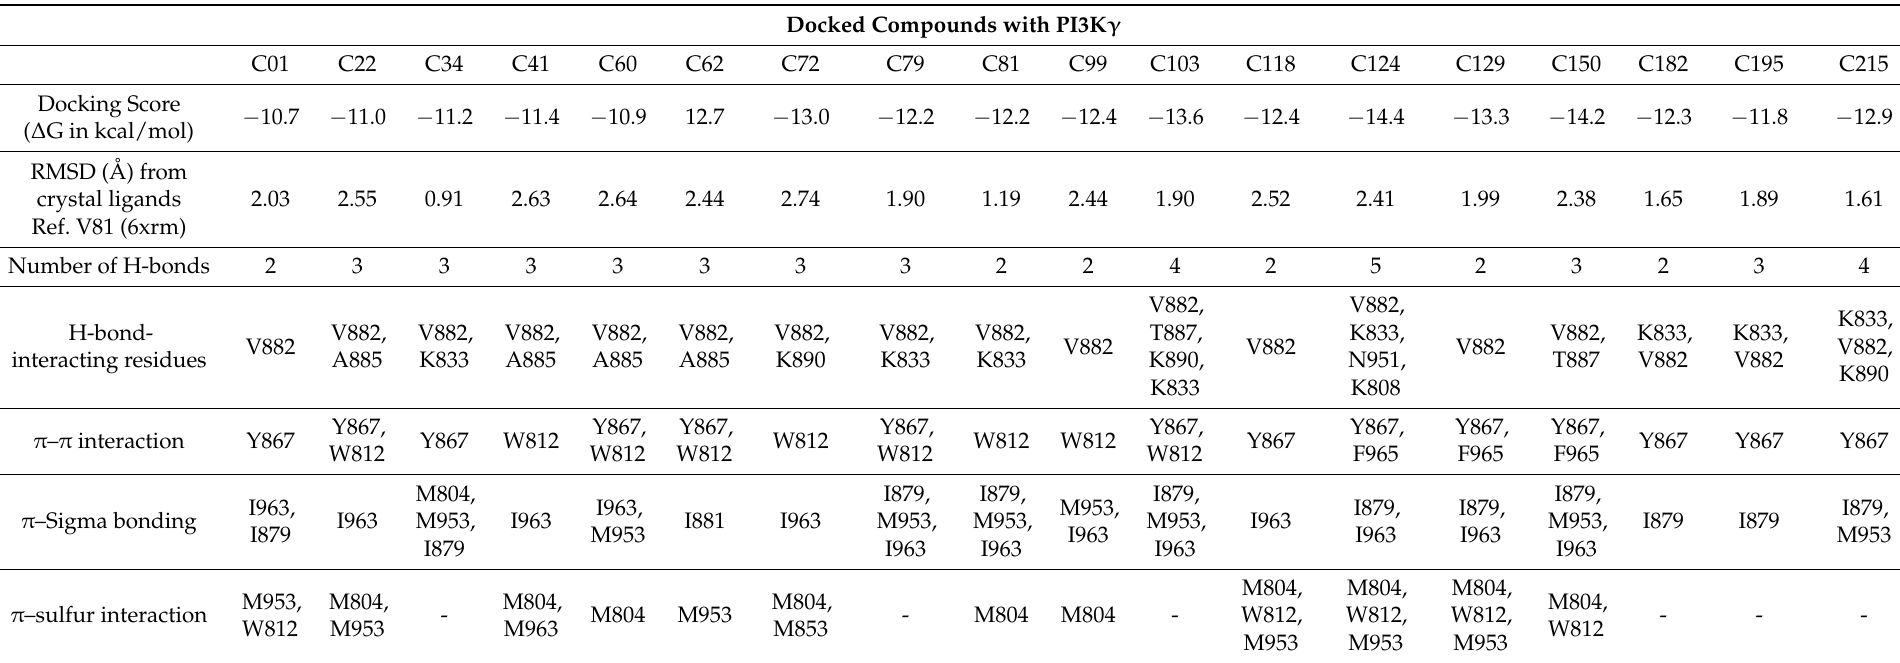
Table 1. Molecular docking analysis of the selected compounds with PI3K γ